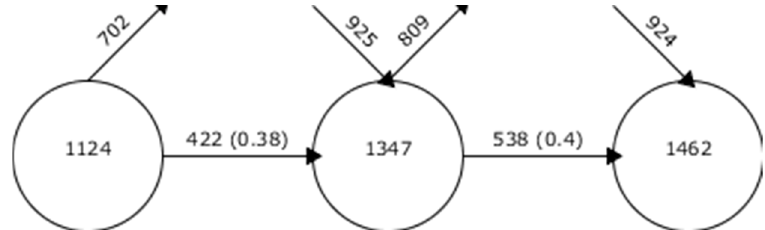
Figure 3. Continuity of keywords between contiguous intervals.